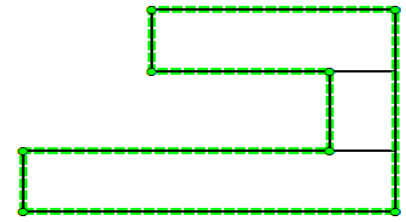
Figure 4. The shortest path that passes the sides of three rectangles by green color.